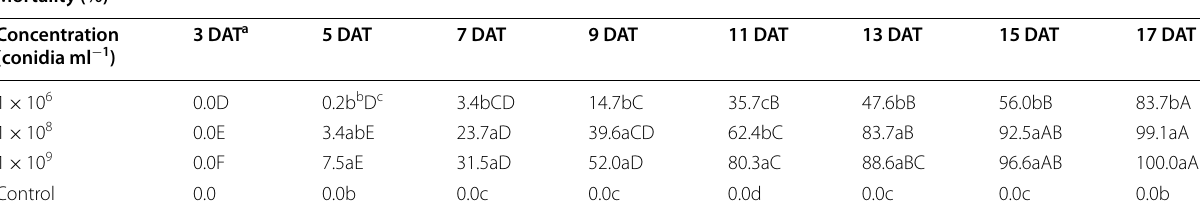
a DAT: Days after treatment